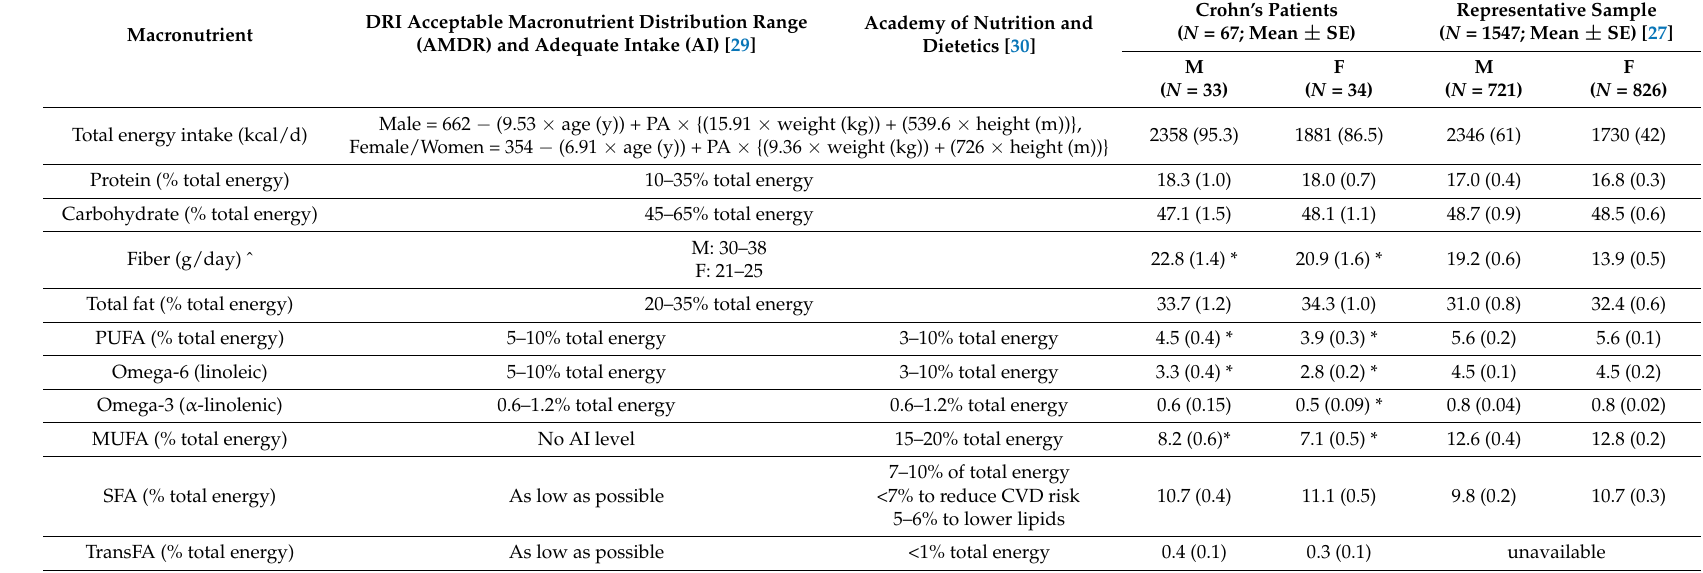
Table 2. Macronutrient composition compared to current